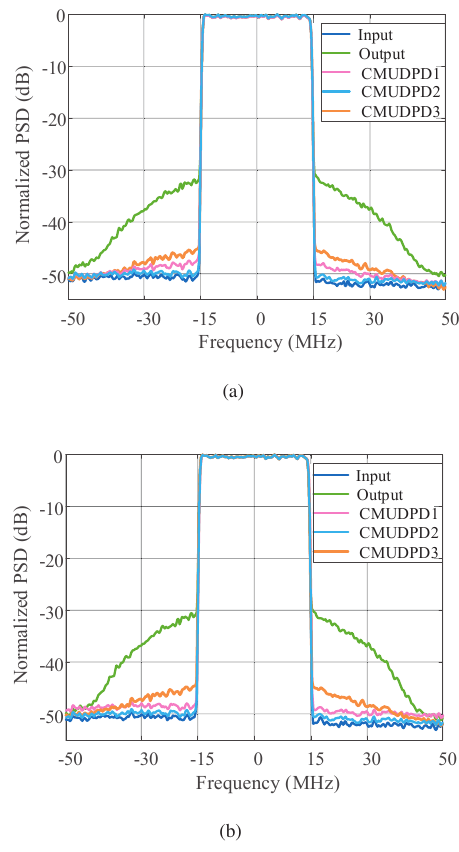
Figure 16. Simulation results of PSDs under an experimentally generated 30 MHz bandwidth signal with (W) and without (W/O) CMUDPD. ( a ) Class AB W and W/O CMUDPD. ( b ) Class A W and W/O